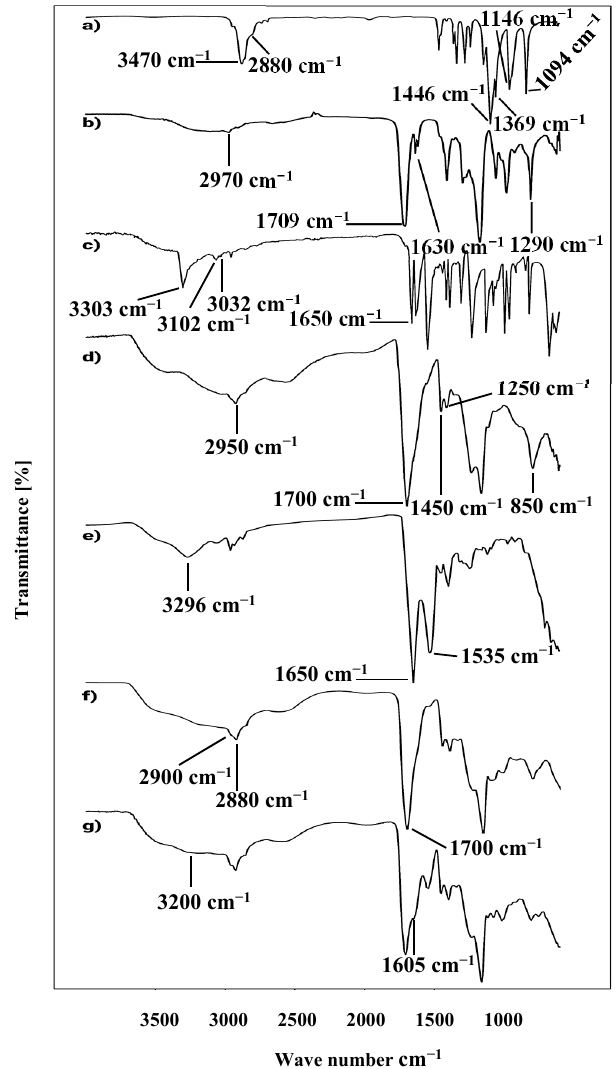
Figure 2. FTIR spectrum of ( a ) PEG-8000, ( b ) acrylic acid, ( c ) MBA, ( d ) carbopol 934, ( e ) bacitracin zinc, ( f ) unloaded formulation, and ( g ) drug-loaded formulation.